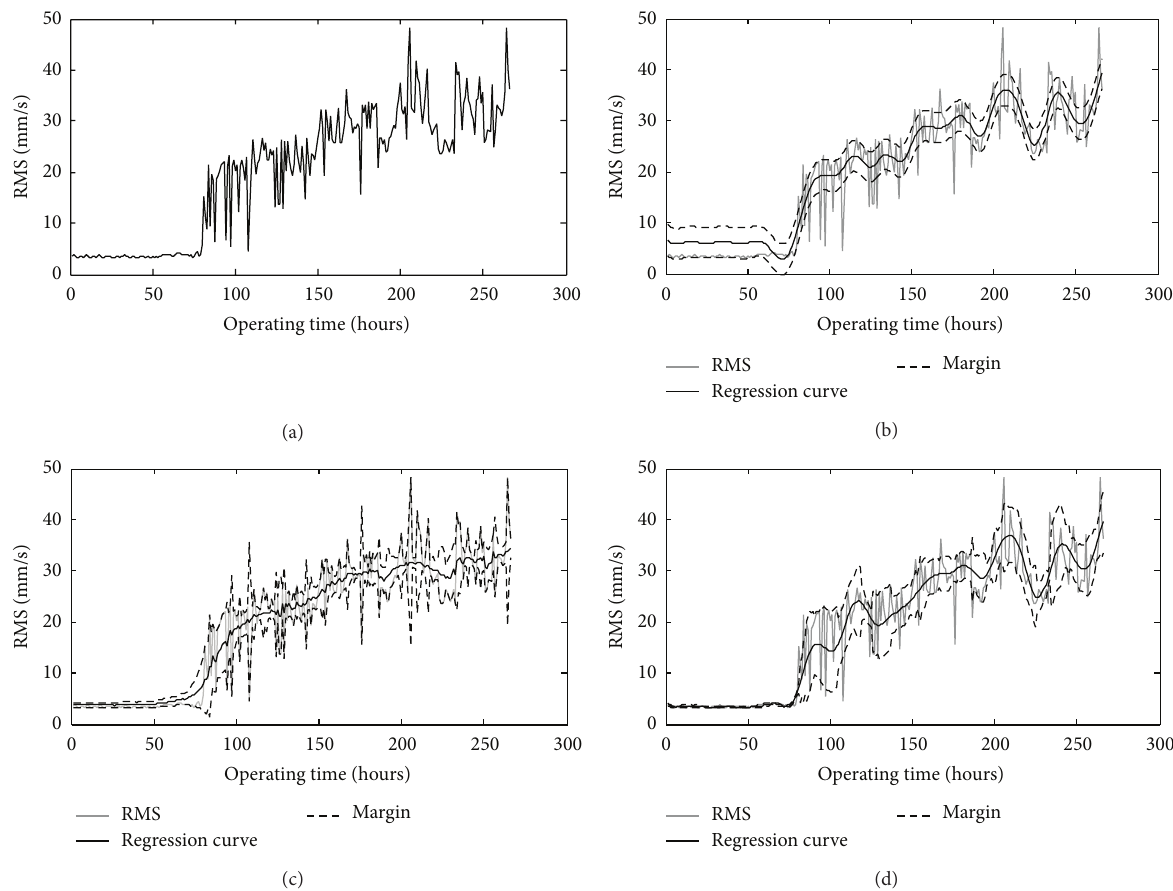
Figure 3: Regression results of the vibration RMS of a descaling pump: (a) time series of the vibration RMS; (b) regression curve of standard SVR; (c) regression curve of LSVR; (d) regression curve of